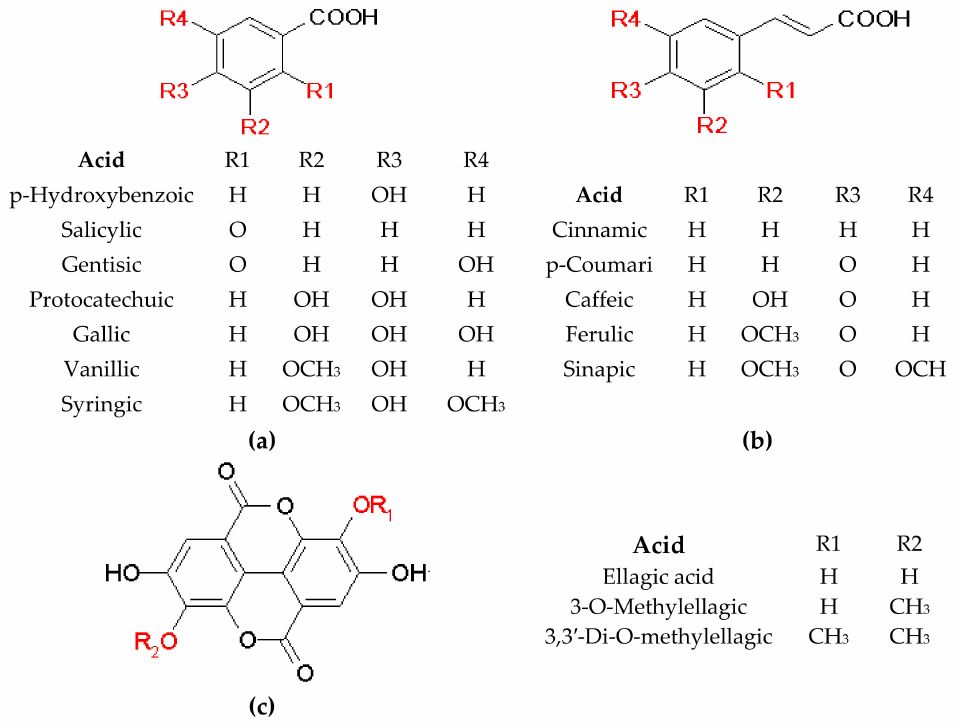
Figure 2. Structures of the most common derivatives of ( a ) benzoic acid, ( b ) cinnamic acid, and ( c ) ellagic acid found in Nepenthaceae and